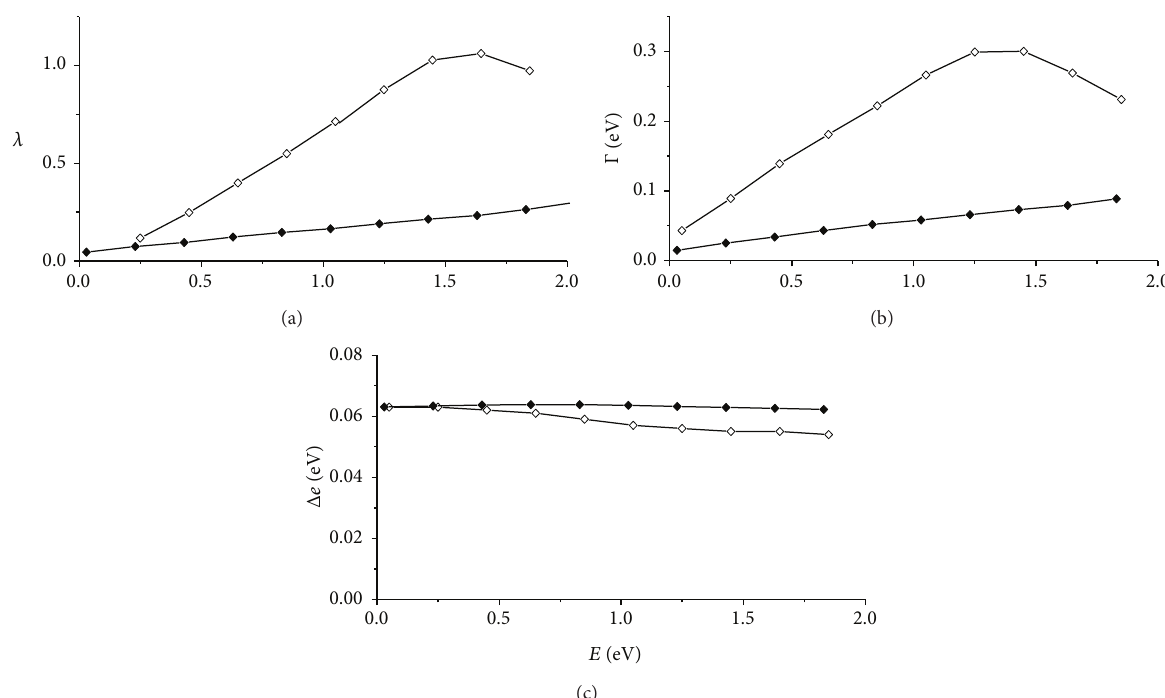
Figure 4: The characteristics of the hole-phonon and electron-phonon relaxation for ZnO depending on the excess energy 𝐸 . The sense of the plots is the same as in Figure